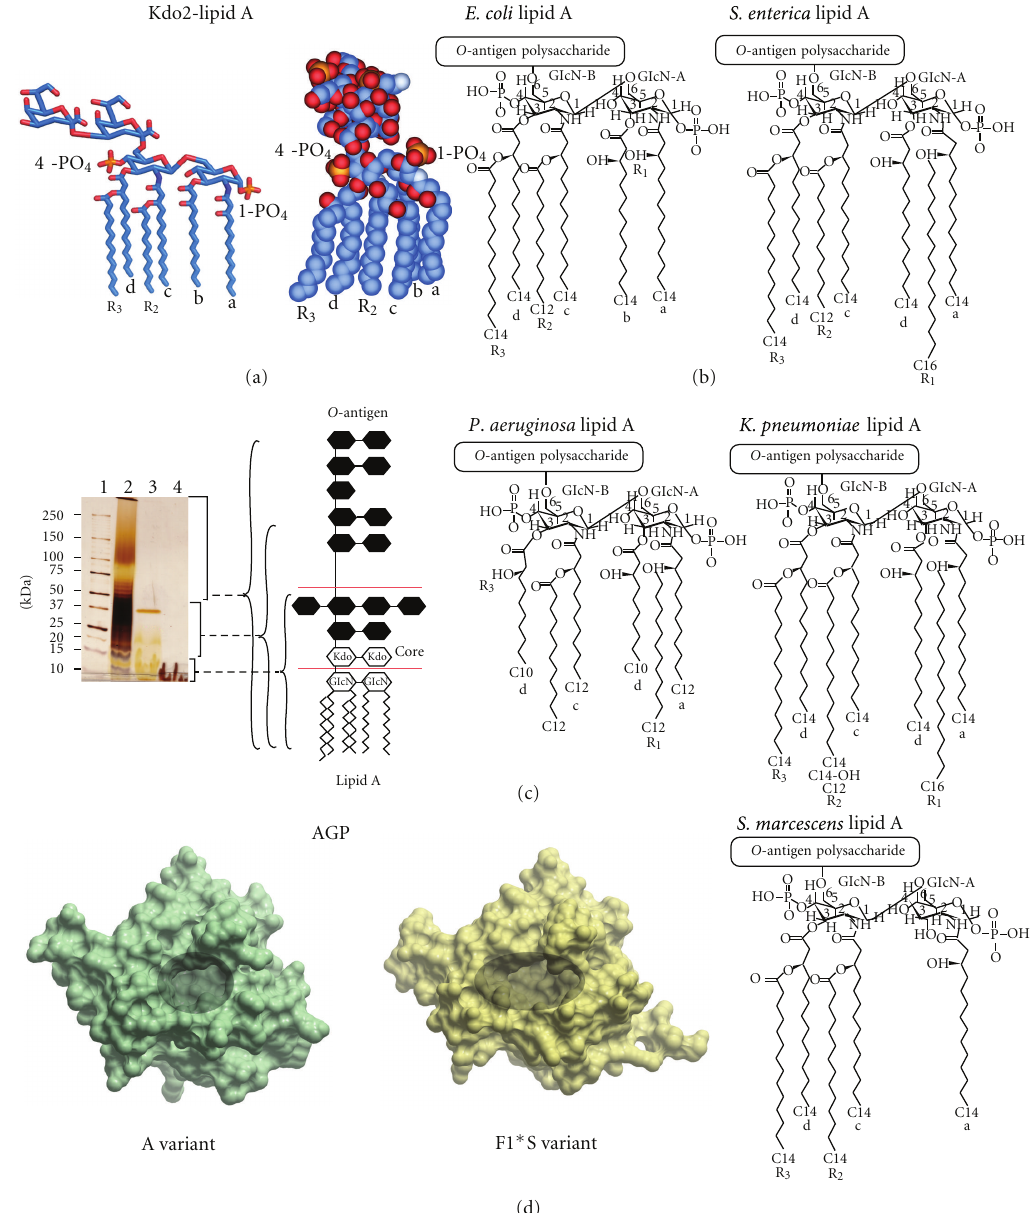
Figure 1: (a) Structure of Kdo2-lipid A shown in stick (left-hand panel) and CPK (right-hand panel) representation. (b) Chemical structures of the lipid A component of the LPS samples used in this study [41–43]. (c) 4–20% SDS-PAGE separation of the LPS samples used in this study. The well samples contained 30 μ g of each LPS sample. The gel was stained by the silver staining technique used for LPS [44]. The structural organization of LPS is shown schematically in the right-hand panel. Lane 1: molecular weight; Lane 2: E. coli O111:B4 LPS; Lane 3: E. coli EH100 (R a ) LPS: Lane 4. E. coli F583 (R d ) LPS. (d) Surface representation of the A (PDB ID: 3APU) and F1 ∗ S (PDB ID: 3KQ0) variants of human AGP. The ligand binding pocket of each variant is highlighted by the shaded